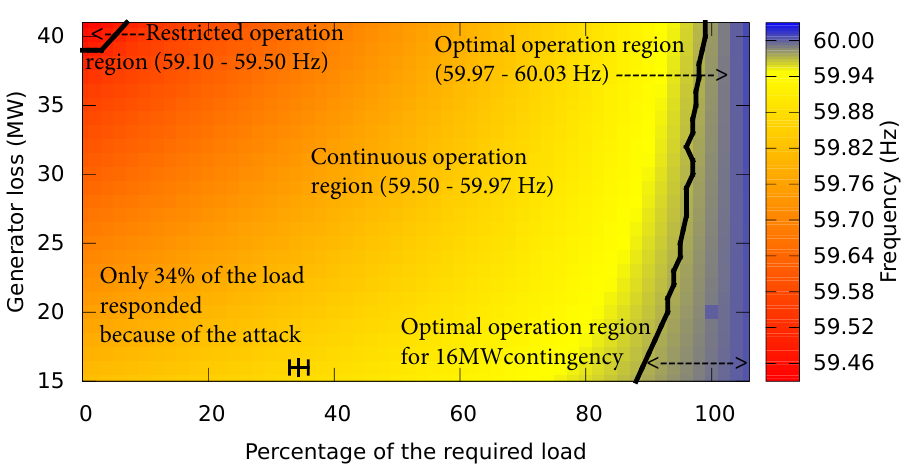
Figure 5. Frequency of the system after 100 s of a contingency ( y -axis) when varied load responds ( x -axis) to the DR request. According to the percentage of load that responds, three regions are created: restricted, continuous and optimal. The figure also demonstrated the impact of the DoS attack when DR responds to a 16 MW contingency. On average, 34% of the load responded as shown in the